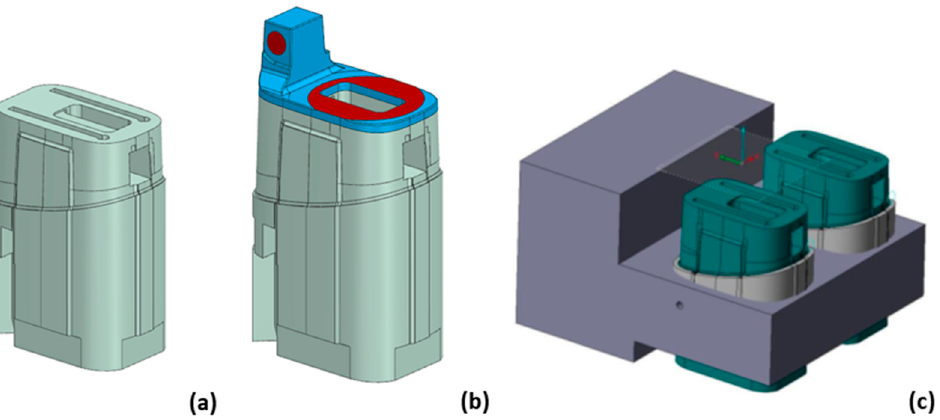
Figure 11. Core insert base model ( a ), model of the complete assembly of the core insert ( b ), and workpiece with reference coordinate frame for the SLM manufacturing process ( c ).